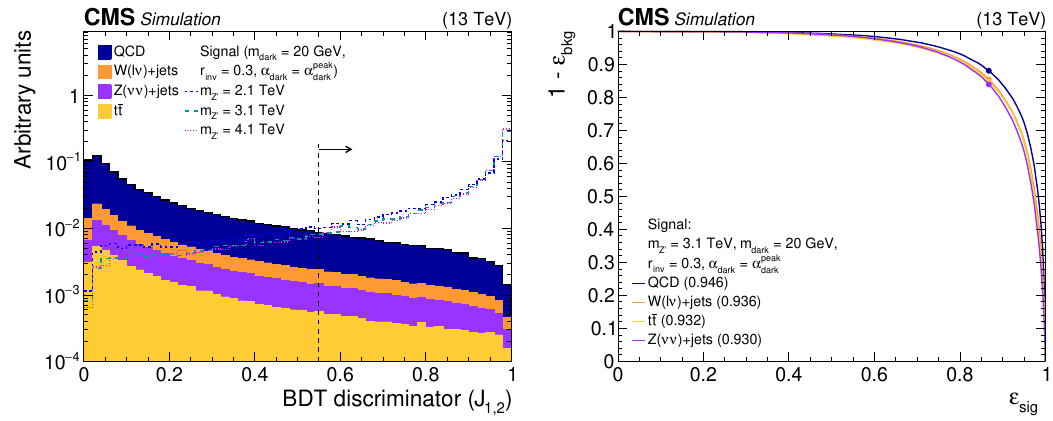
jets from the T jets, comparing the simulated T